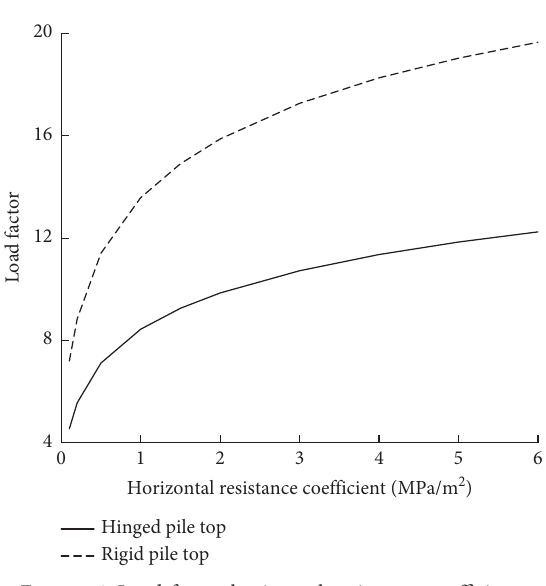
Figure 6: Load factor-horizontal resistance coefficient.